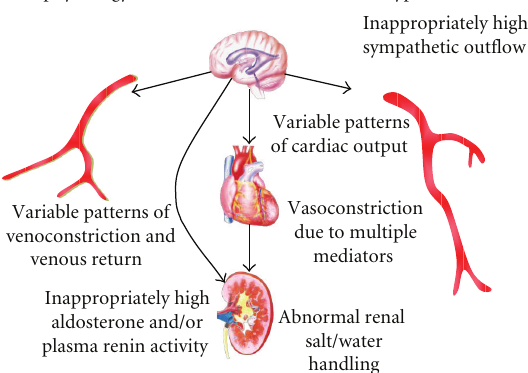
Figure 1: Demonstrates pathophysiology of resistant hypertension. Increased sympathetic outflow is a fundamental abnormality in most